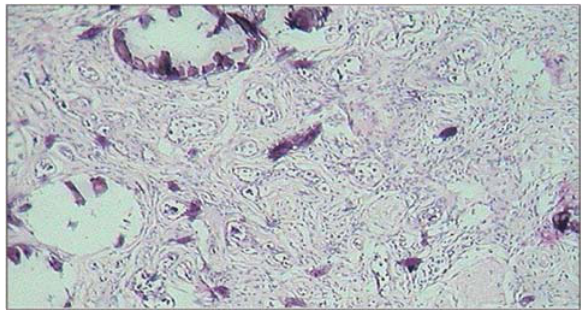
Figure 2. Gonadoblastoma with abundant calci fi ed areas. (H&E X20)